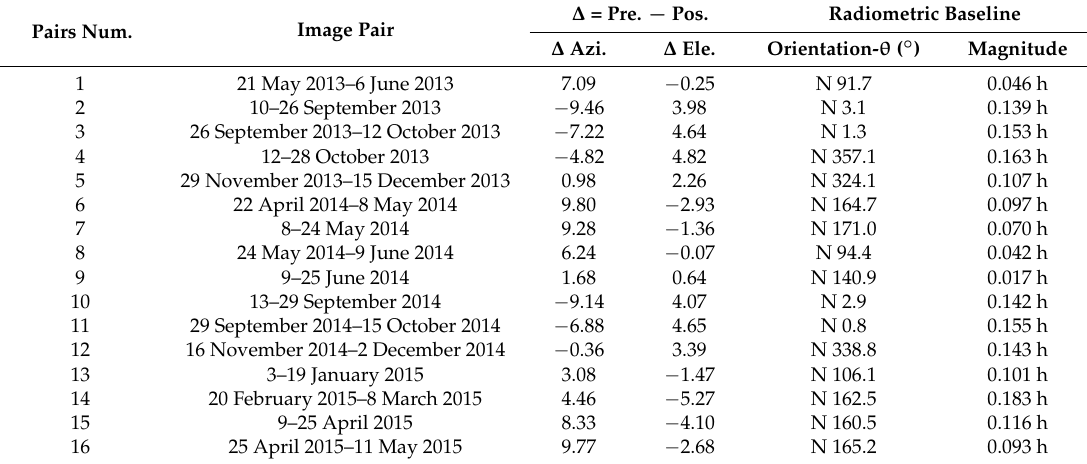
∆ = Pre. − Pos. Table 2. Radiometric baseline list of the Landsat 8 correlation image pairs. ∆ = Pre. − Pos. Radiometric Baseline